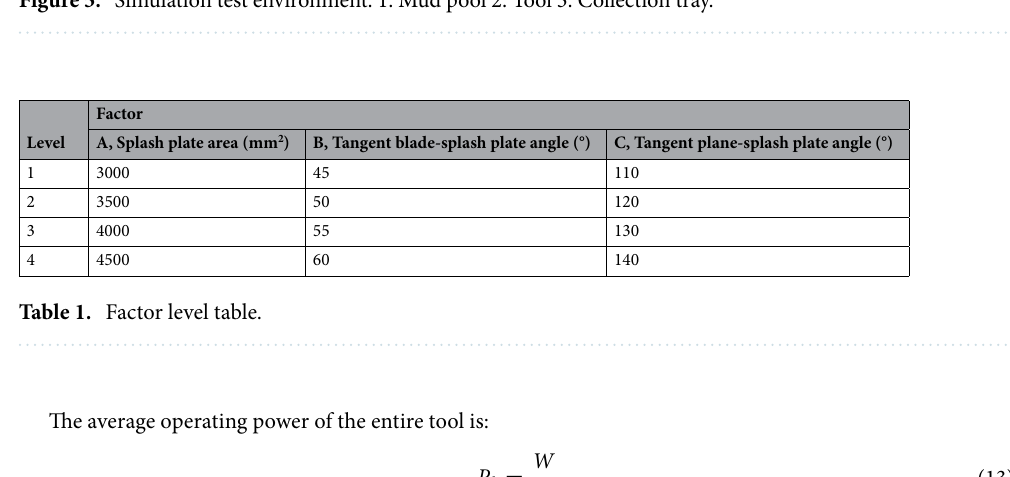
Figure 5. Simulation test environment. 1. Mud pool 2. Tool 3. Collection tray.